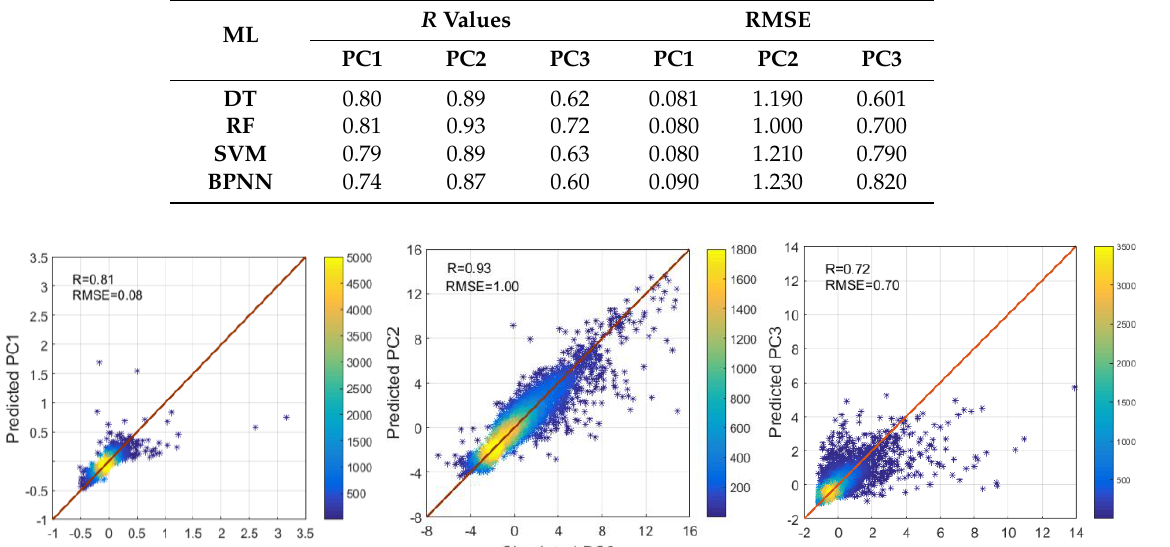
Table 1. The prediction of R values and root mean square error (RMSE) for principal component (PC1, PC2, PC3) on the algorithms model of four machine learning. DT: decision tree, SVM: support vector